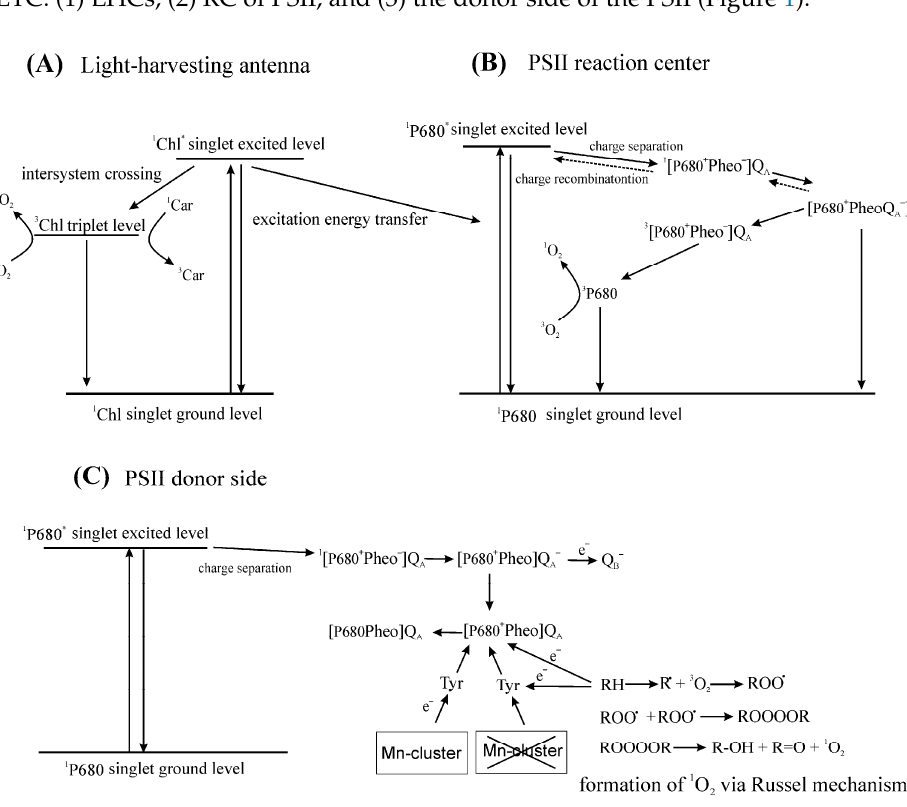
10 ns [204]. It was found that an increase in absorption at 820 nm is immediately followed by a multiphasic decay, including a major fast phase within 5–10 µs and an intermediate phase (about 10%–15% of the signal) within 2 ms [204]. Interestingly, O 2 does not affect the decay. It can be speculated that this indicates that O 2 is unable to efficiently quench 3 P700 in isolated PSI complexes and thereby produce 1 O 2 . It seems that, even if 3 P700 is formed in PSI, its quenching by O 2 is minimized. It has also been suggested that charge recombination mainly occurs between P700 + and phylloquinone A 1 − , which minimizes the formation of 3 P700 triplet [205]. 1 O 2 could be detected in PSII membrane fragments and PSII core complexes but not in PSI particles under the same conditions [181]. However, isolated PSI-LHCI